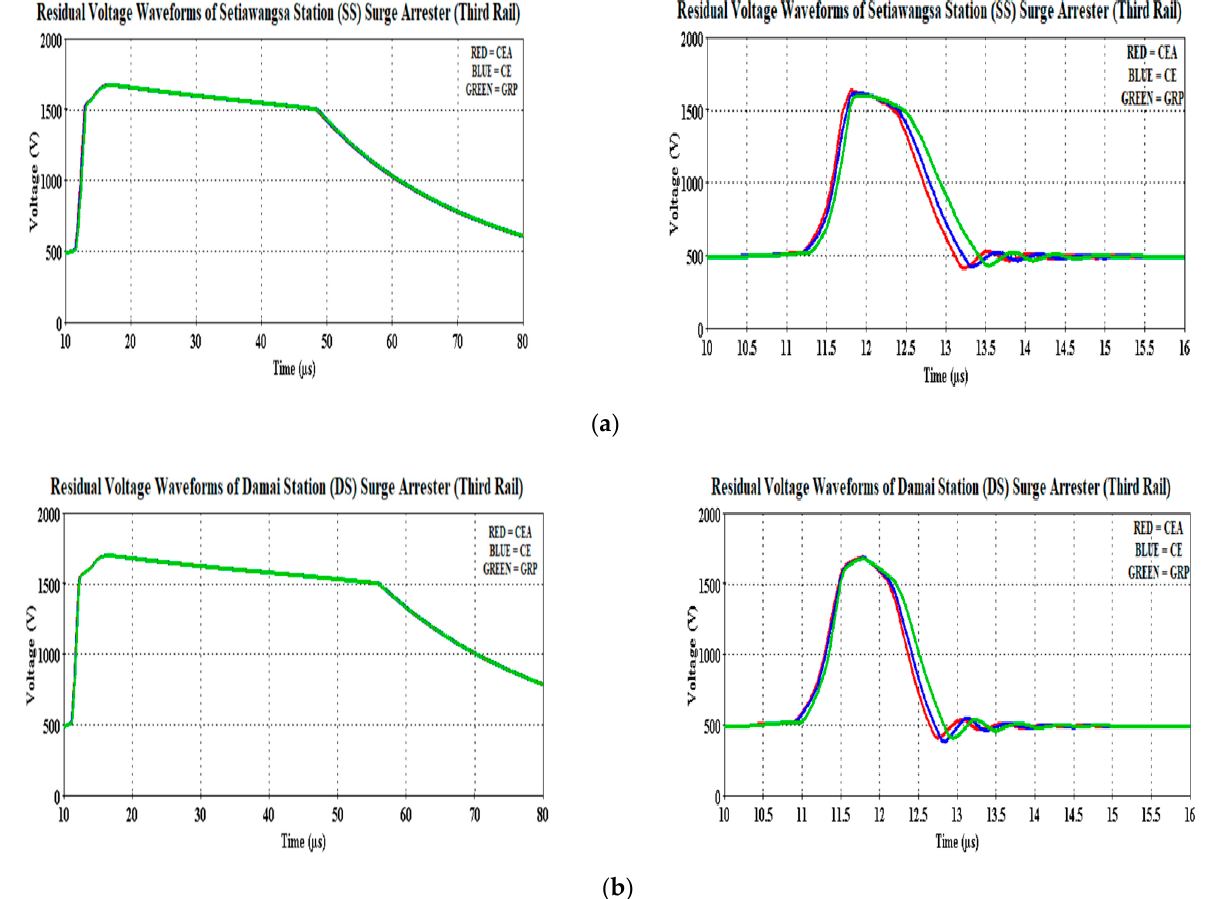
Figure 10. Residual voltage waveforms of the ( a ) Setiawangsa Station and ( b ) Damai Station surge arresters for both 30 kA ( left ) and 90 kA ( right ).